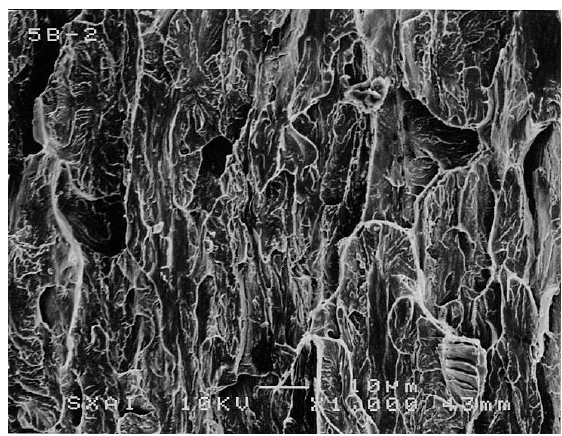
Figure 15. Fracture appearance of the 90° propagation step: enlarged and oriented cleavage.